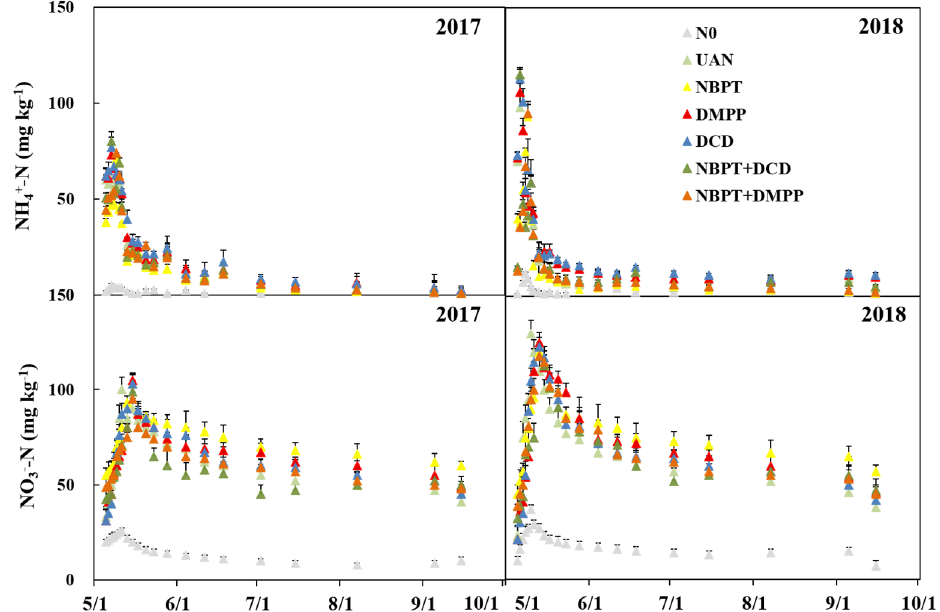
Figure 4. NH 4+ -N and NO 3 − -N content in the soil of different fertilizer after fertilization, bars are standard error of the mean.